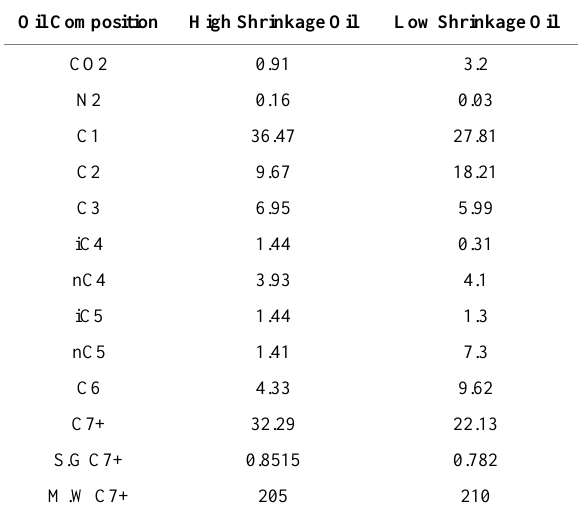
Table 3. Oil compositions used in